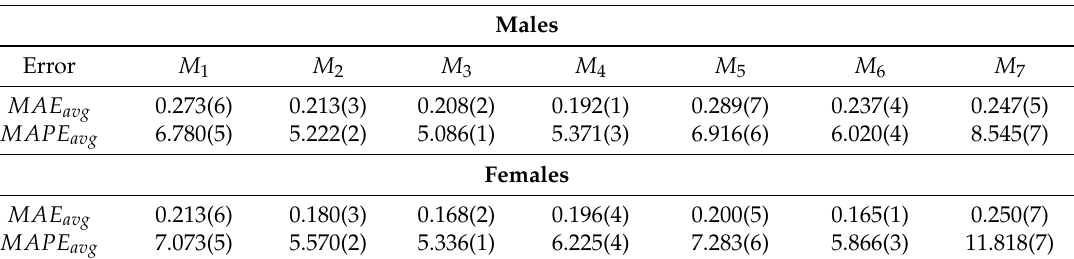
The probabilities of death in the last year of the fitting